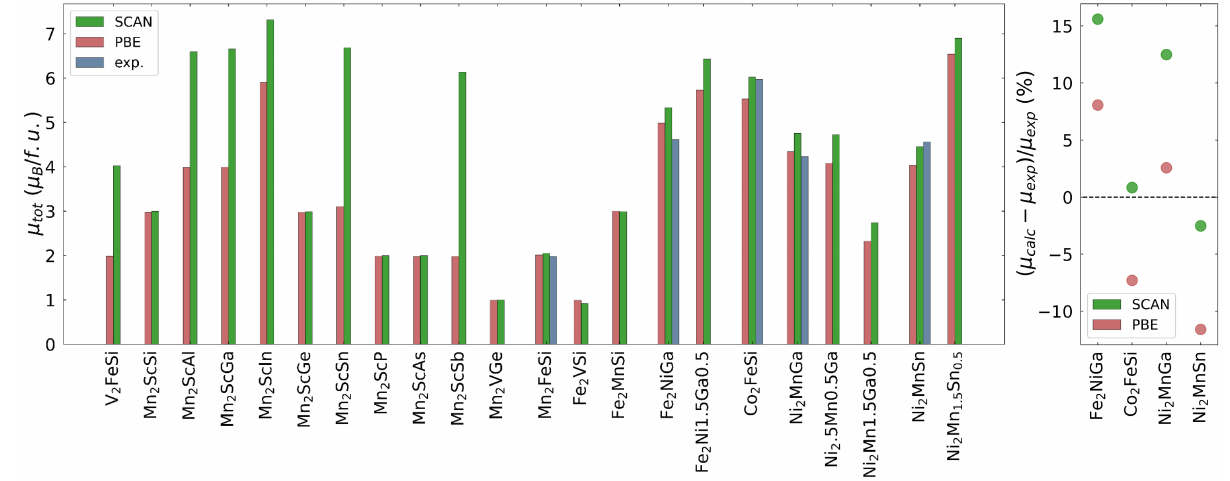
Figure 17. ( left panel ) The total magnetic moments for half- and full-Heusler alloys cal- culated by SCAN and PBE. The deviation of the calculated µ tot from experimental one is plotted in the ( right panel